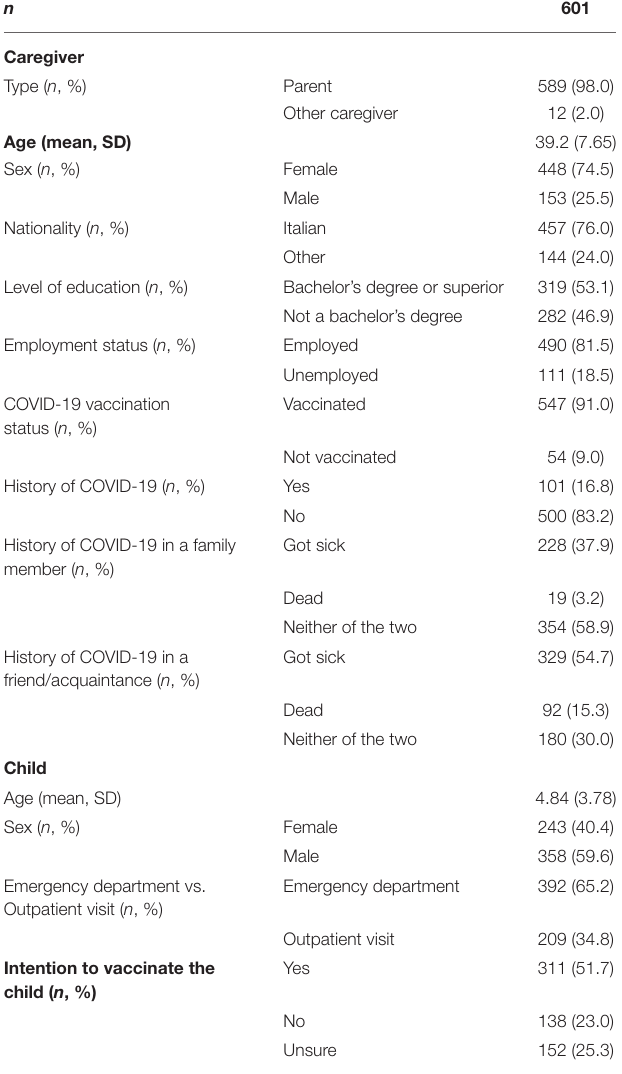
TABLE 1 | Characteristics of enrolled caregivers and their